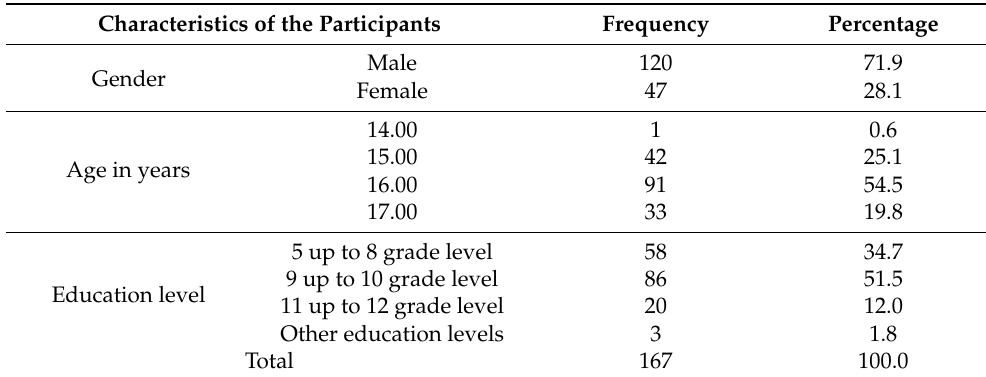
Table 2. The demographics of the study participants involved in filling out the open-ended items of the